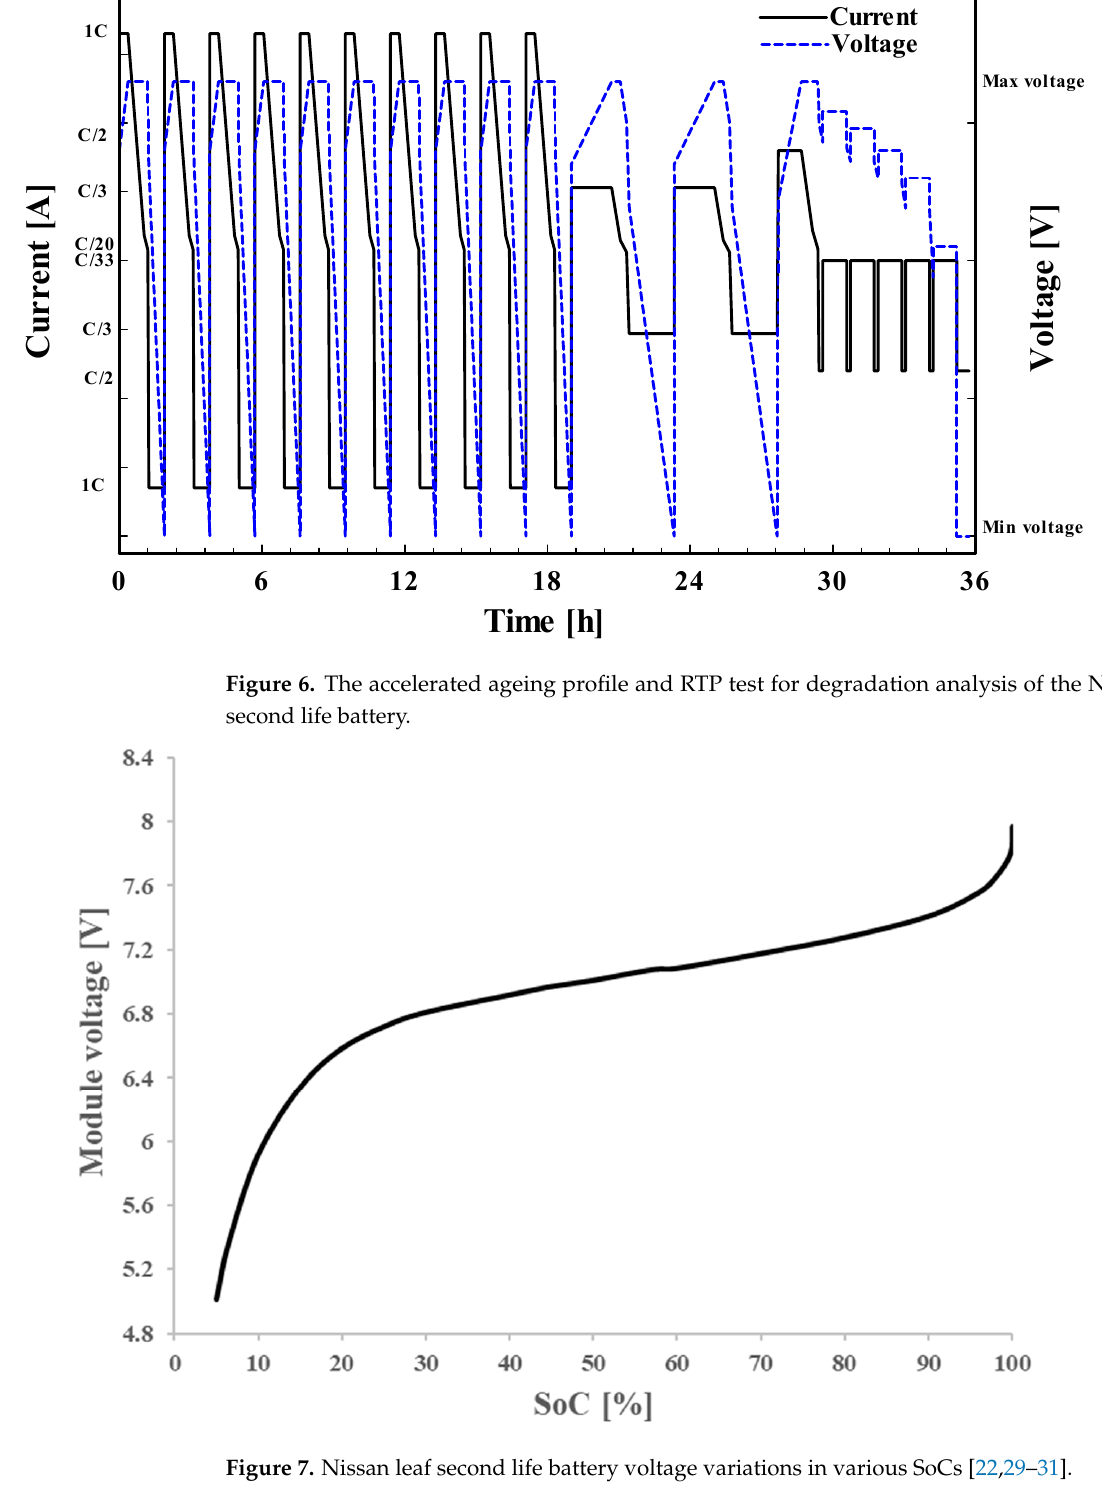
Figure 8. Nissan leaf second life battery capacity fade in various discharge cycles [22,29–31]. Figure 9. Nissan leaf second life battery voltage fade in various discharge cycles [22,29–31].